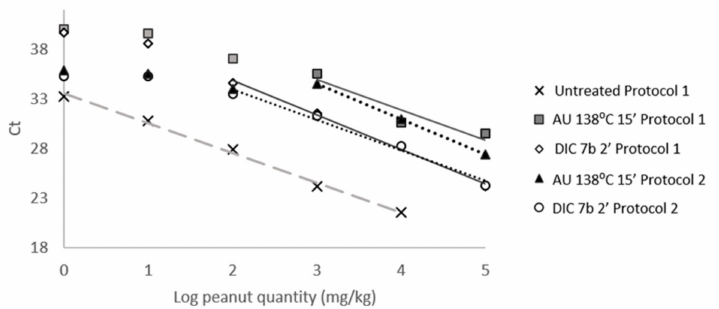
Figure 4. Influence of the DNA isolation method in the performance of mat K detection in processed matrices. Amplification of mat K was analyzed in two treated peanut samples, by AU 138 ◦ C 15 min and DIC 7b 2 min, which DNA was isolated by protocols 1 and 2. Curves were performed by plotting mean Ct and log of the peanut quantity. As a reference, a curve performed with untreated peanut in wheat is included, using protocol 1 for DNA isolation